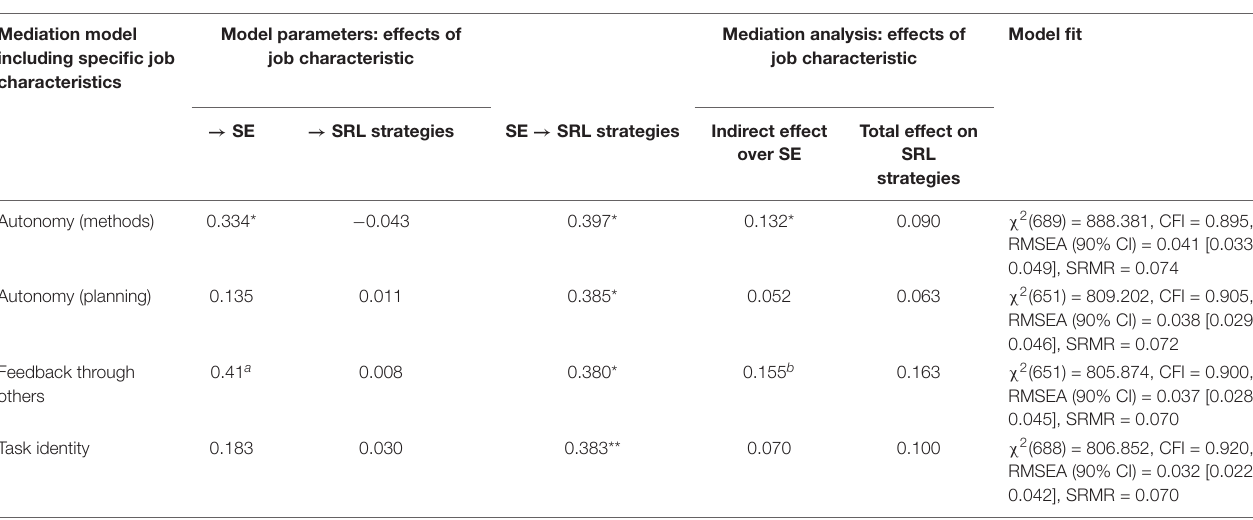
FIGURE 3 | Structural equation model showing the relations of the job context (organizational learning culture and job characteristics) to mastery-approach goal orientation, self-efficacy, and SRL strategies. Coefficient is significant at the 0.05 level *, at the 0.01 level **, at the 0.001 level ***. Paths which are n.s. are gray colored. N = 170. The model fit is χ 2 (206) = 1605.411, CFI = 0.861, RMSEA (95%CI) = 0.044 [0.038; 0.050], SRMR = 0.080. TABLE 4 | Results of mediation analysis for different job